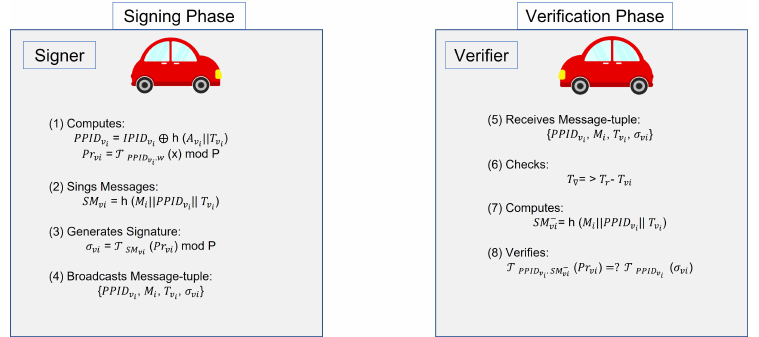
Figure 3. Signing and verification